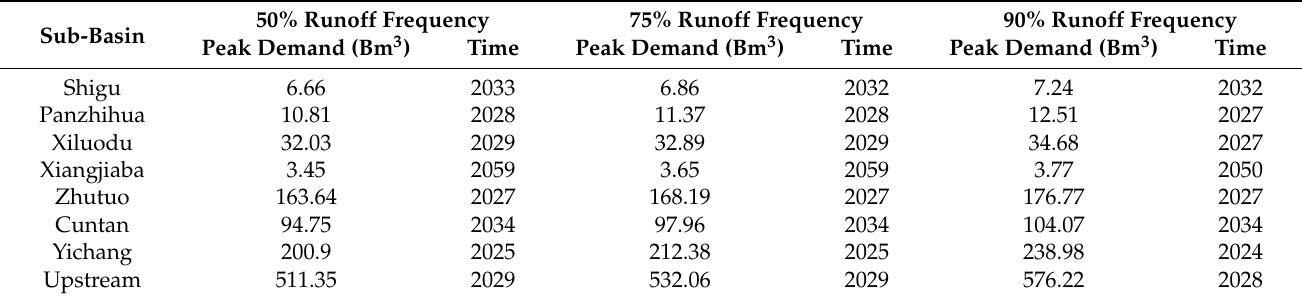
Table 6. Peak water demand in upstream Yangtze River and sub-basins from 2016 to 2100.